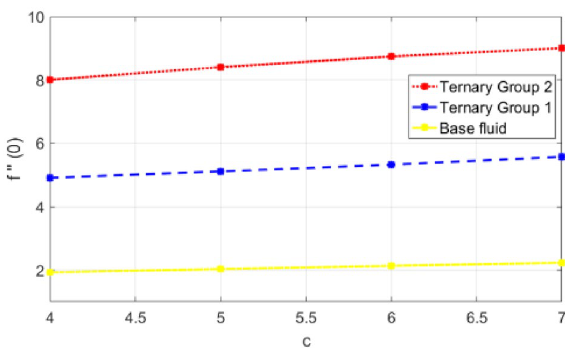
Figure 16. Variation in skin friction against stretching ratio (c) along x-direction.